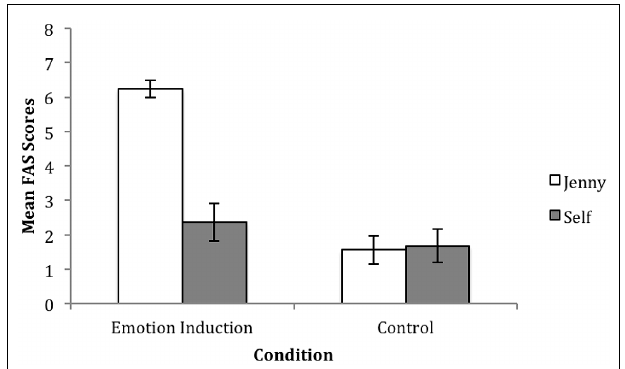
FIGURE 3 | Mean ratings for Jenny and self on the FAS, with standard error bars, for the emotion induction and control group in study two (3-year-olds). Possible scores ranged from “0” (very happy) to “8” (very sad).